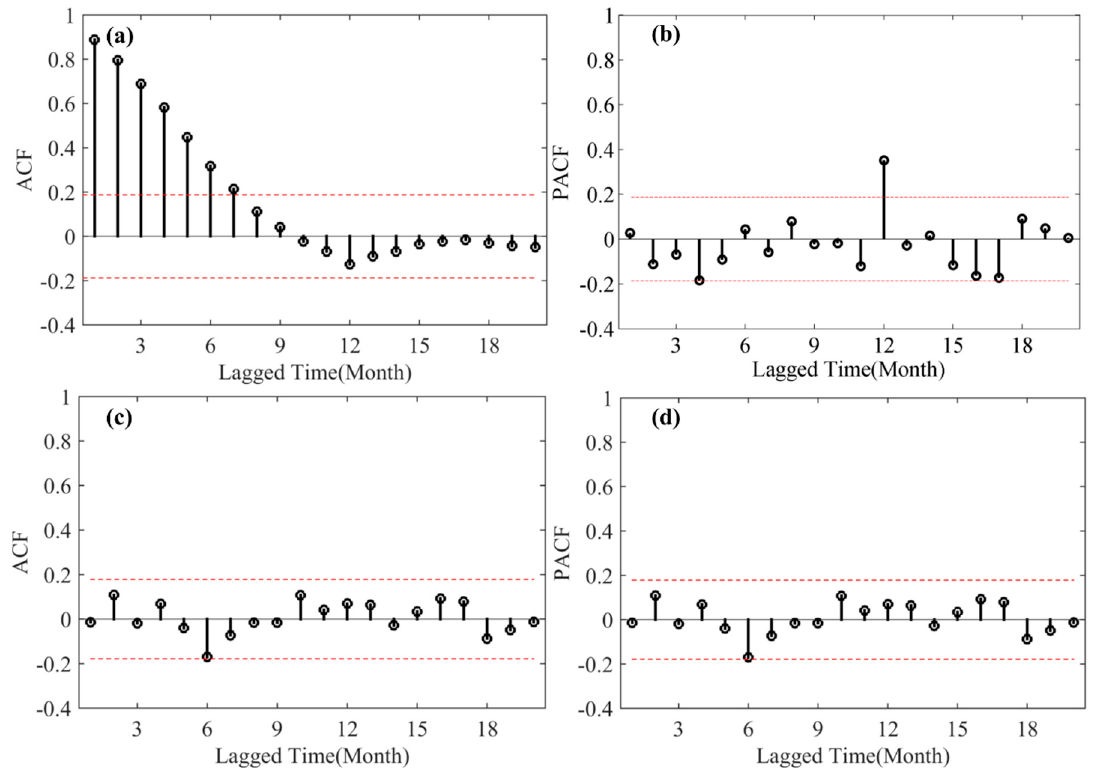
Figure 5. ( a ) Sample ACF of seasonally differenced GRACE-derived ∆ GWS data; ( b ) PACF of seasonally differenced GRACE-derived ∆ GWS data; ( c ) Sample ACF of residuals ARIMA (1,0,1) (1,1,1) 12 and ( d ) PACF of residuals ARIMA (1,0,1) (1,1,1) 12 for the sample grid. Table 1. AIC and BIC values for different models.